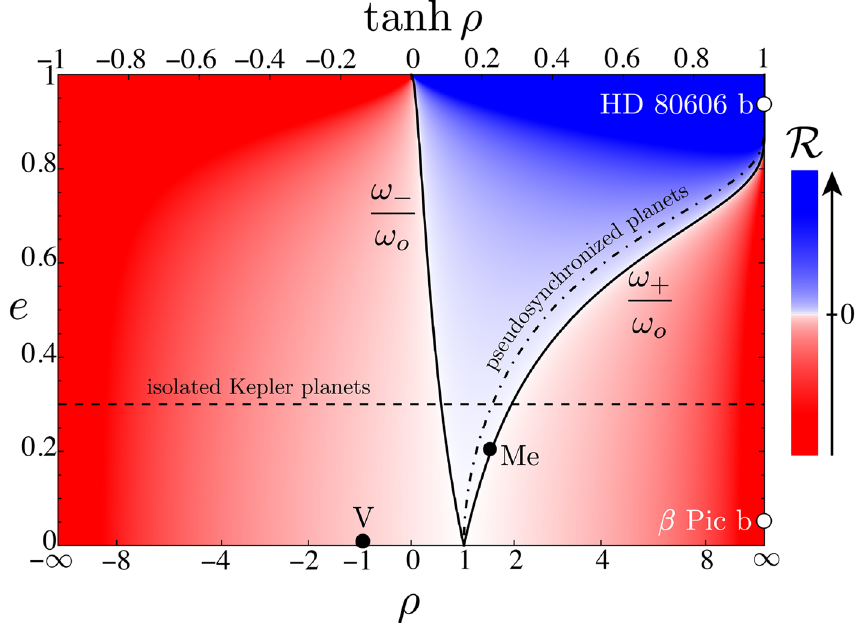
Figure 1. Reversals plot. Spin–orbit ratio ρ = ω s /ω o increases rightward and orbital eccentricity e increases upward for zero tilt. Red-white-blue background colors represent the product R of the differences of the planet’s spin angular speed and its extreme orbital angular speeds at apoapsis and periapsis; red means no apparent solar reversals, blue means reversals, and the saturation indicates the reversal magnitude. Black dots are planets Venus and Mercury; white dots are exoplanets β Pictoris b and HD 80606 b. Dashed horizontal line indicates numerous isolated Kepler planets with as yet undetermined spins. Dot-dashed curve indicates potentially pseudosynchronized planets, all of which would undergo reversals.